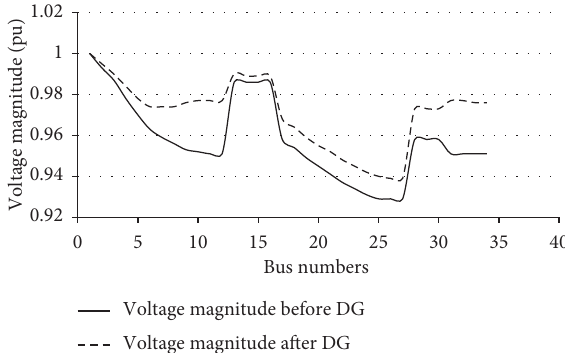
Figure 4: Bus voltages before and after the DG